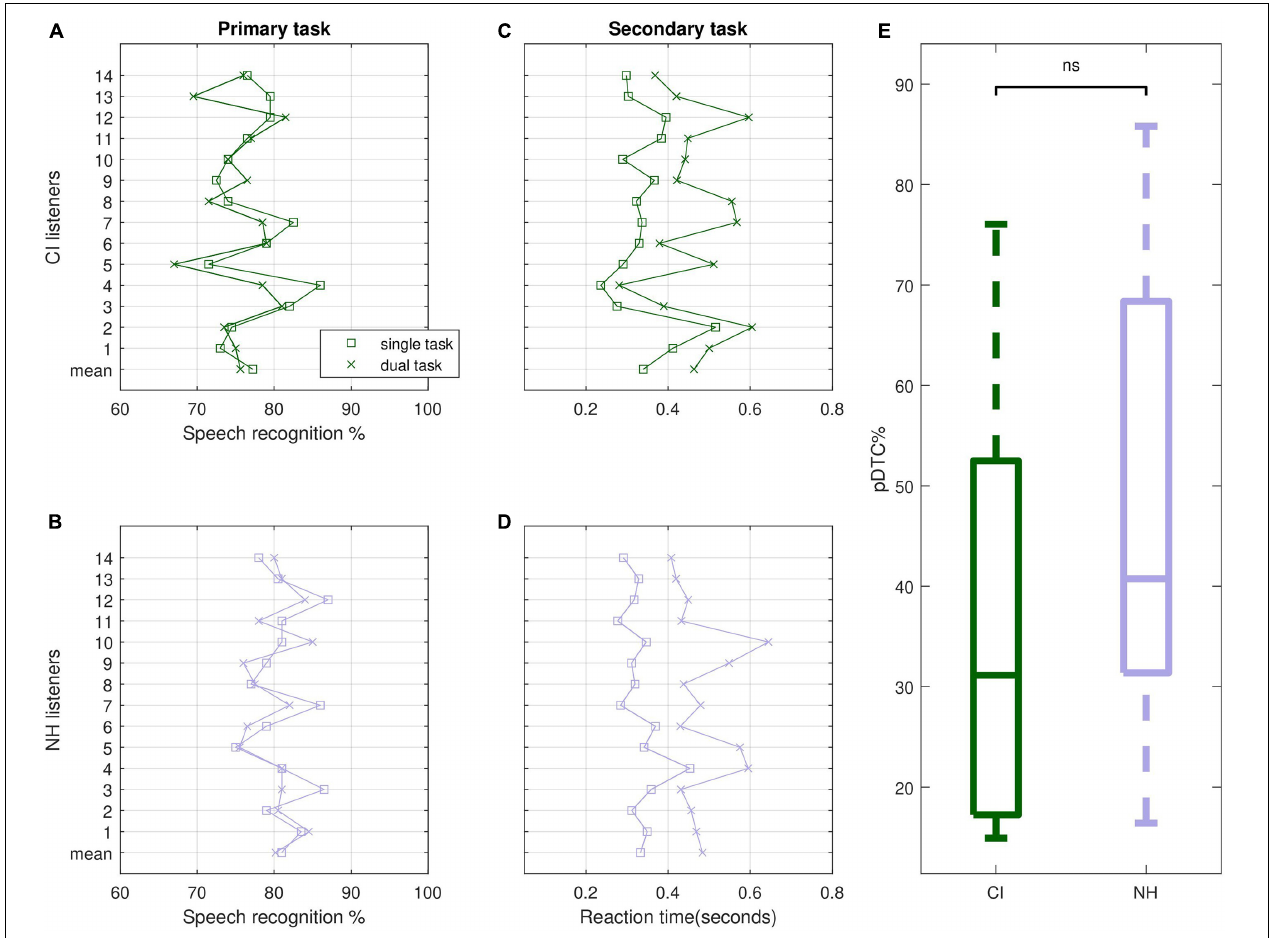
FIGURE 4 | Outcome of the dual-task paradigm. (A,B) Primary task (speech recognition) in CI and NH listeners, (C,D) secondary task (reaction time) in CI and NH listeners, (E) proportional dual-tasks costs for the secondary task. CI, cochlear implant recipients; NH, normal-hearing listeners. Squares = single-task, crosses =